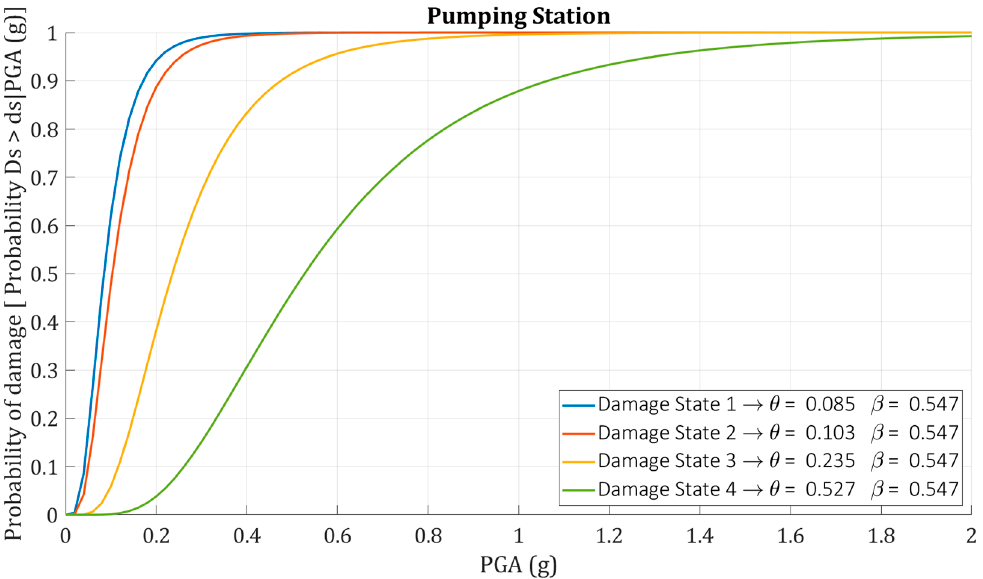
Figure 2. The exclusive fragility curves that were derived for an oil pumping station (based on [51]).